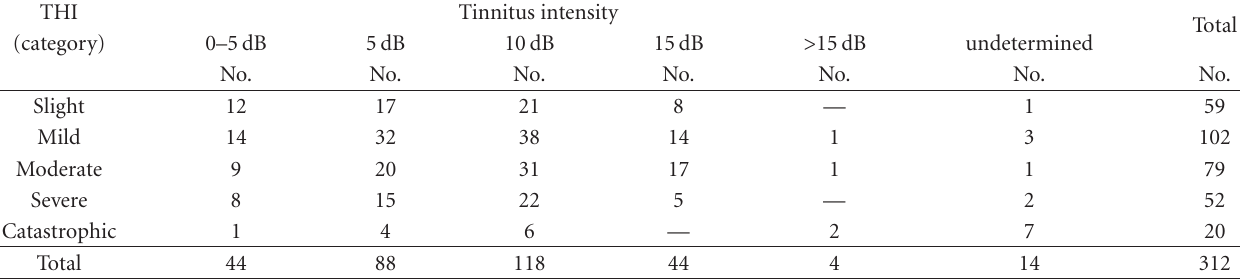
Table 5: Distribution of 312 subjects according to tinnitus-matched loudness and Tinnitus Handicap Inventory.